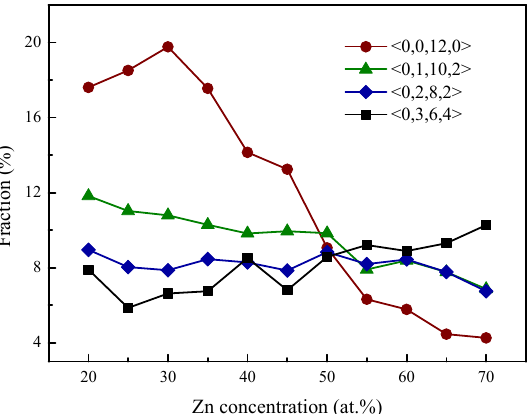
Figure 6. The variations in the fractions of the prevailing local clusters for (Al 50 Mg 50 ) 100 − x Zn x (x = 30, 50, and 70 at.%) MGs.